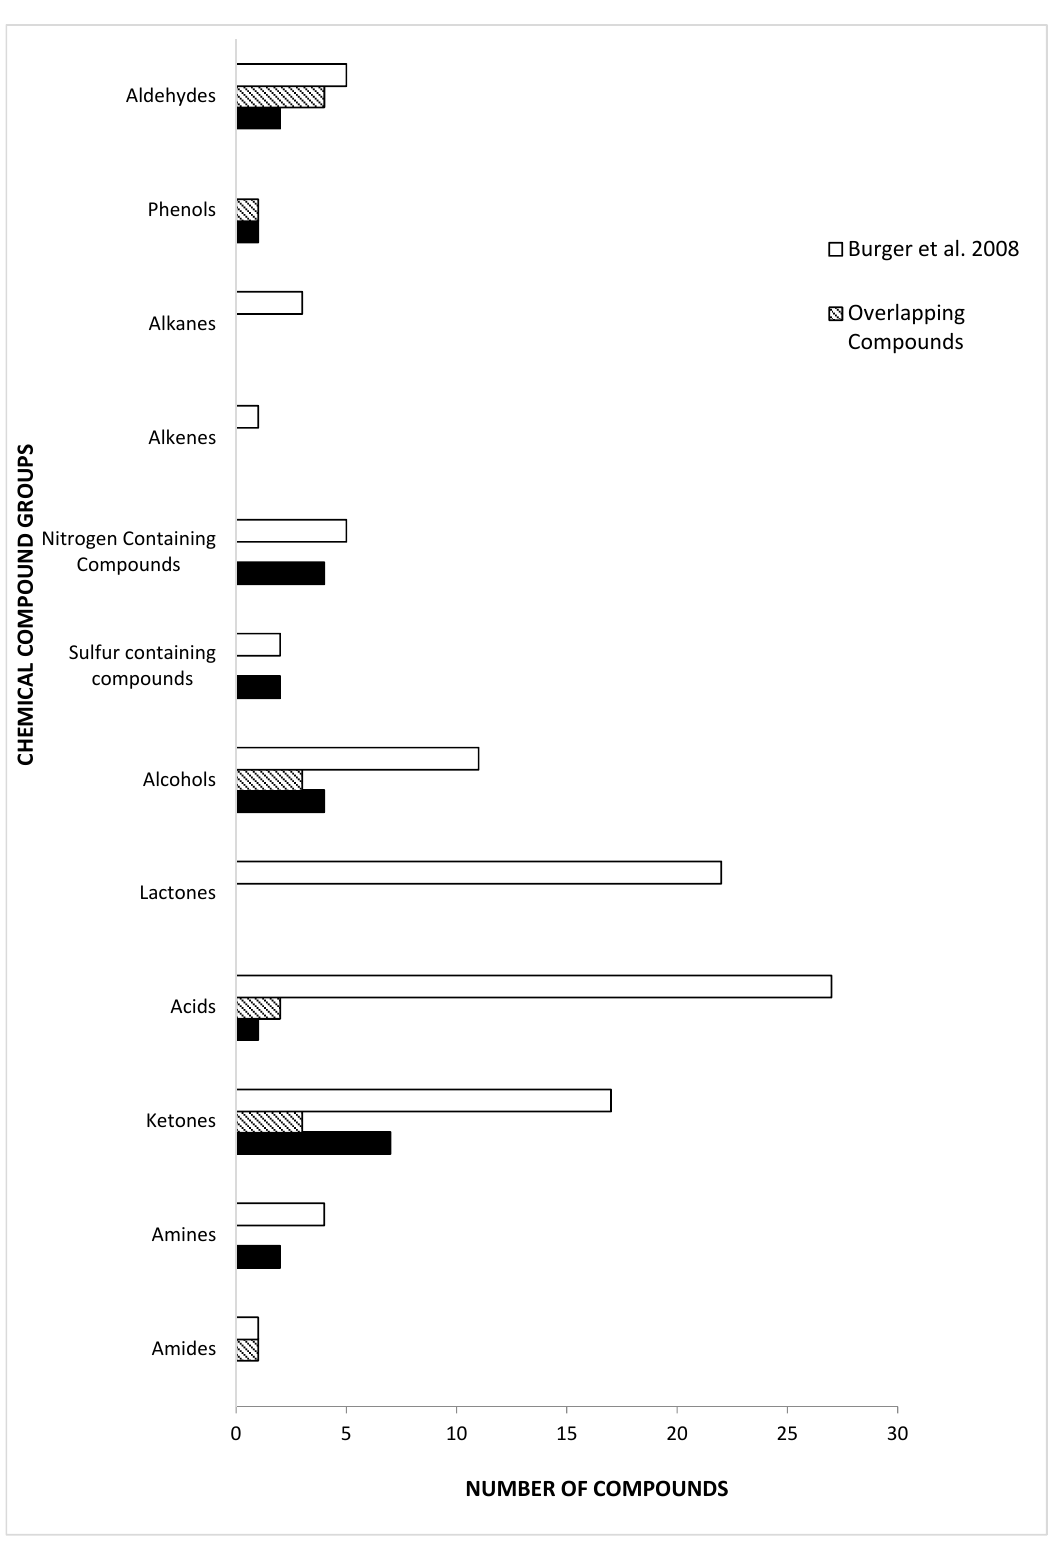
Figure 2. Comparison of chemical compound groups and number of identified with previously published P. tigris tigris urine and marking fluid compounds by Burger et al. [11].